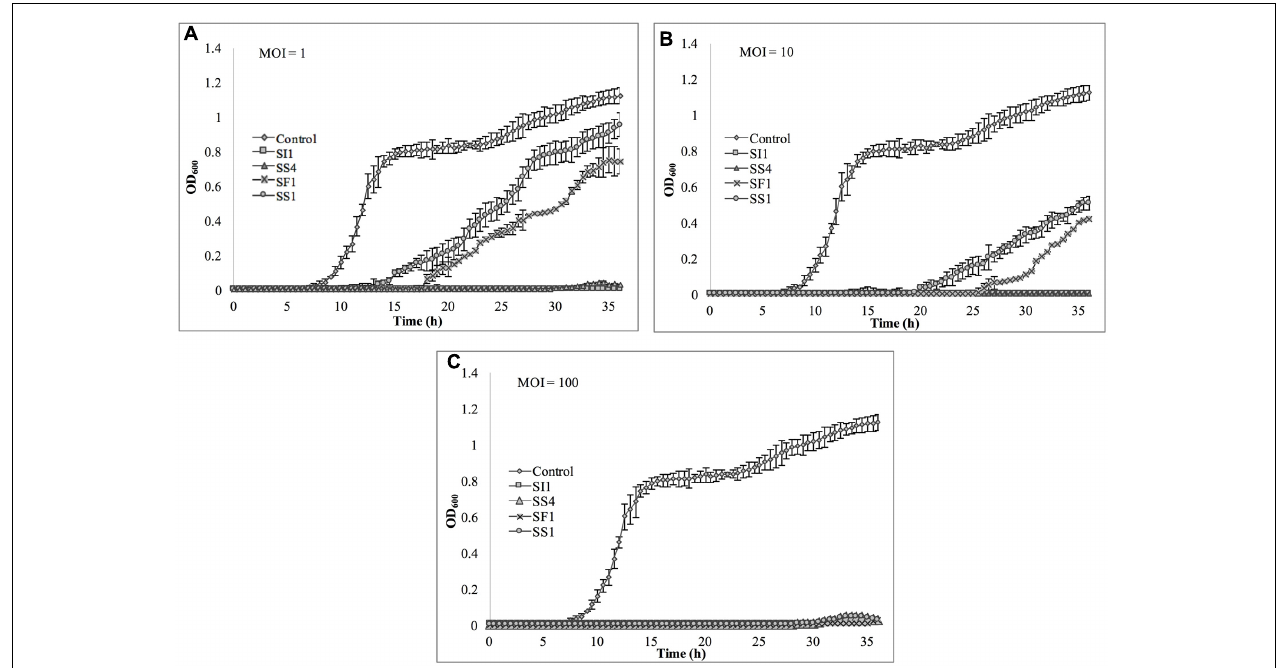
FIGURE 6 | In vitro analysis of S. Enteritidis inhibition by phages SI1, SS4, SF1, and SS1 at (A) MOI = 1, (B) MOI = 10, and (C) MOI = 100. Data shown are the mean of three replicates ± SD.